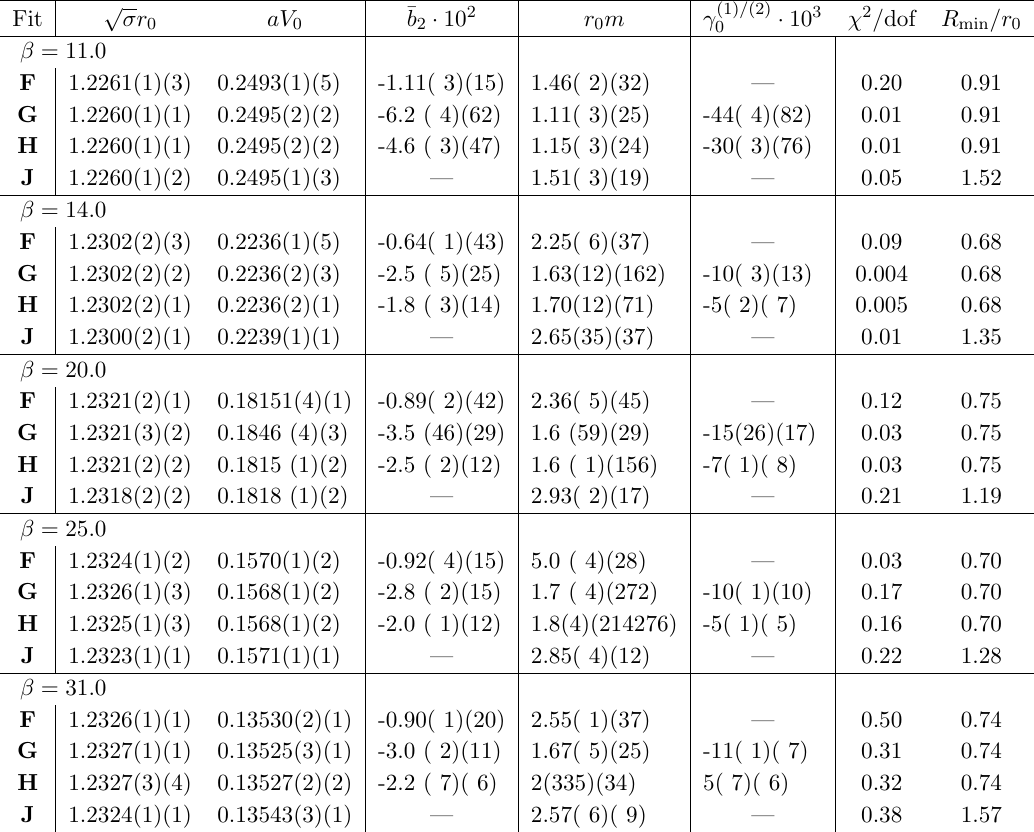
Table 10 . Results of the (cid:12)ts for the extraction of (cid:22) b 2 and m for SU(3) gauge theory. r 0 m the ansatz